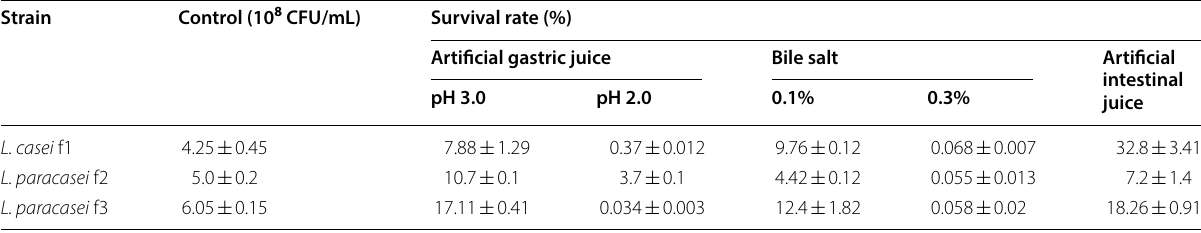
Table 3 The tolerant capacity of the strains to the simulated gastrointestinal environment